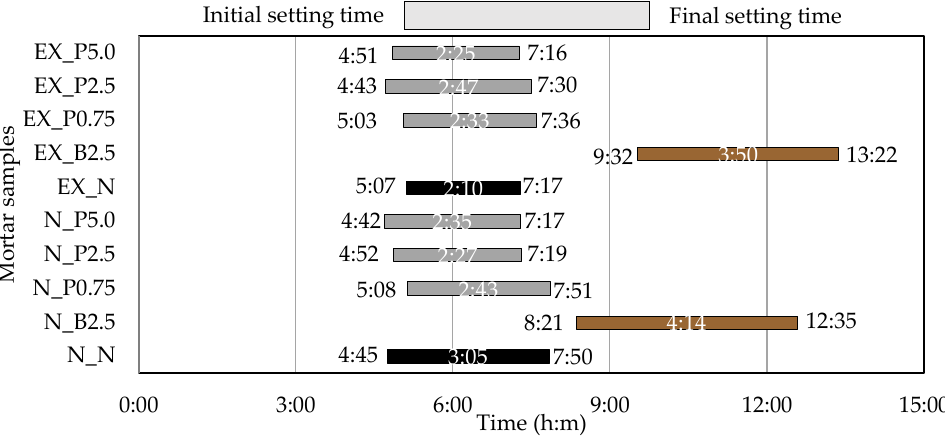
Figure 5. Setting times in ordinary and expansive mortars. (black: without NFBC, brown: with NFBC type B f , grey: with NFBC type P f ).